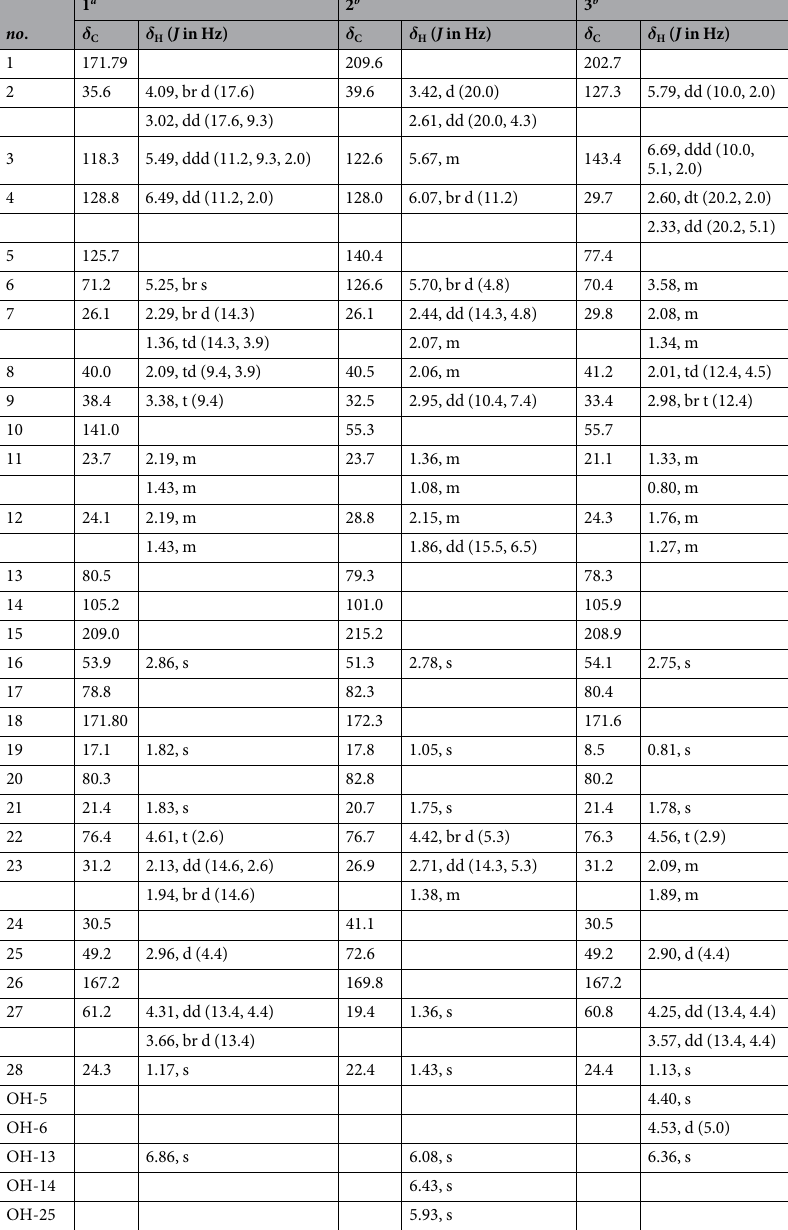
Table 1. 1 H and 13 C NMR data of compounds 1 − 3 . a 1 H NMR spectra recorded at 600 MHz, 13 C NMR spectra 100 MHz, DMSO- d 6